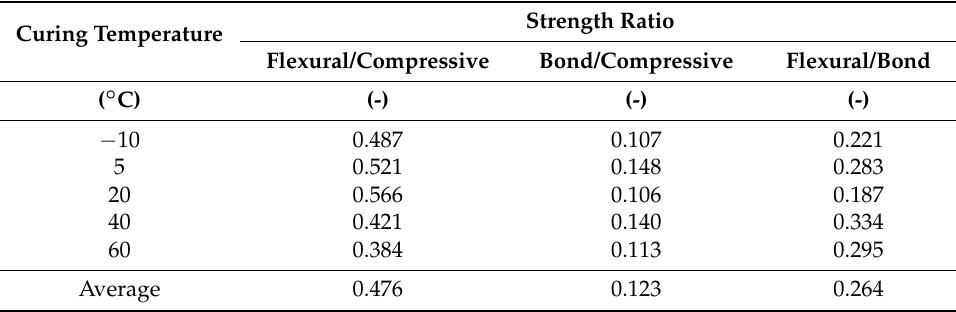
Table 8. Summary of strength ratios of polysulfide polymer